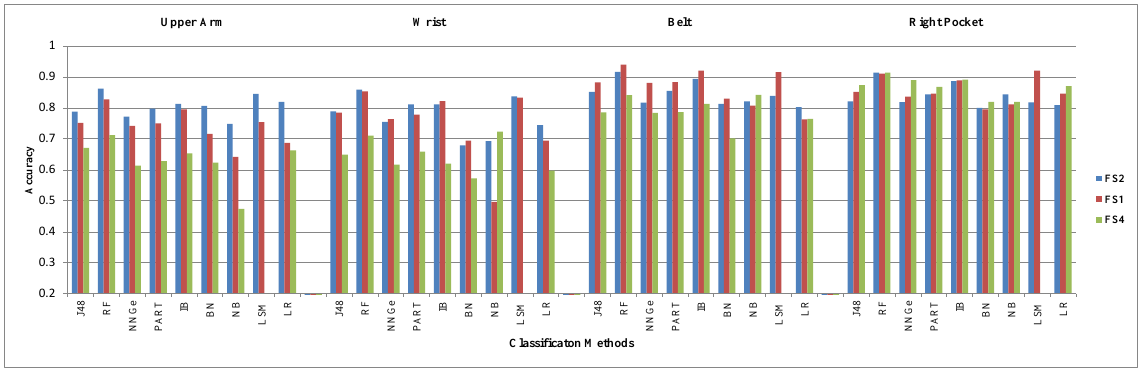
Figure A.7. Accelerometer true positive rate (TPR) for the walking upstairs activity for all four positions and three feature